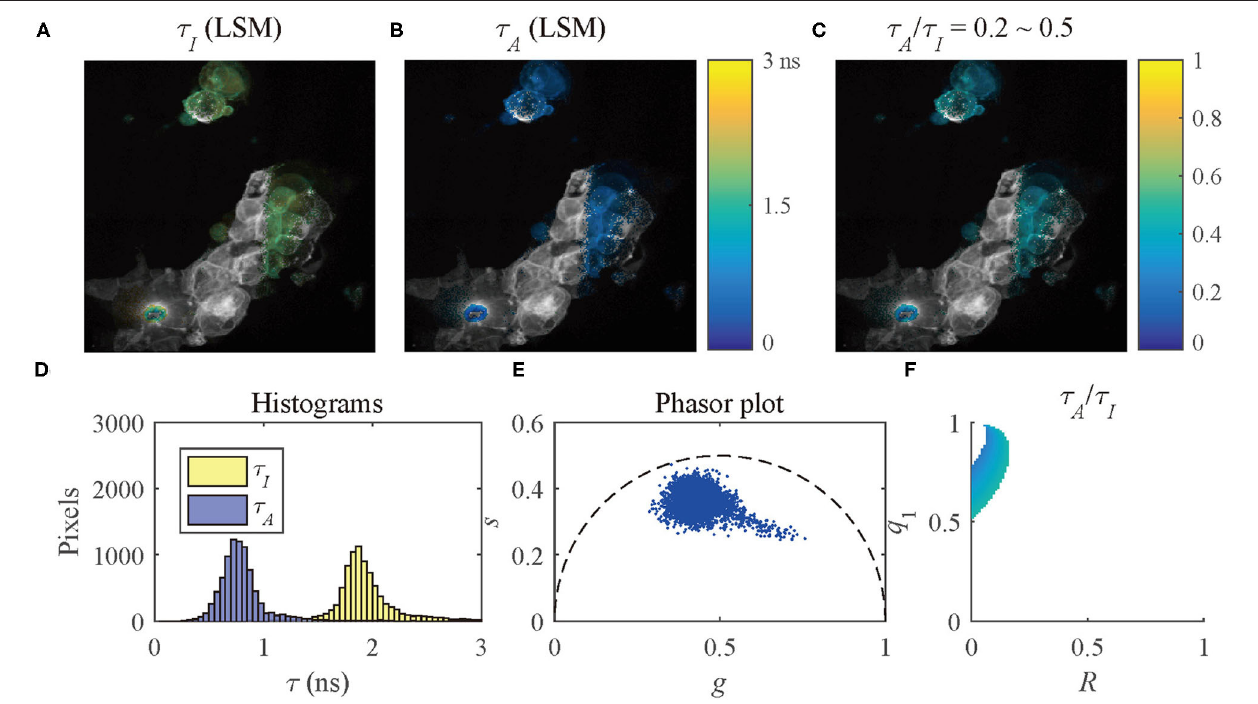
FIGURE 10 | (A) τ I -intensity image, (B) τ A -intensity image evaluated by LSM-2, (C) τ A /τ I ratio image, (D) histograms of τ I (yellow) and τ A (blue), (E) phasor plot, and (F) distribution of τ A /τ I of the selected pixels in (C) with τ A /τ I